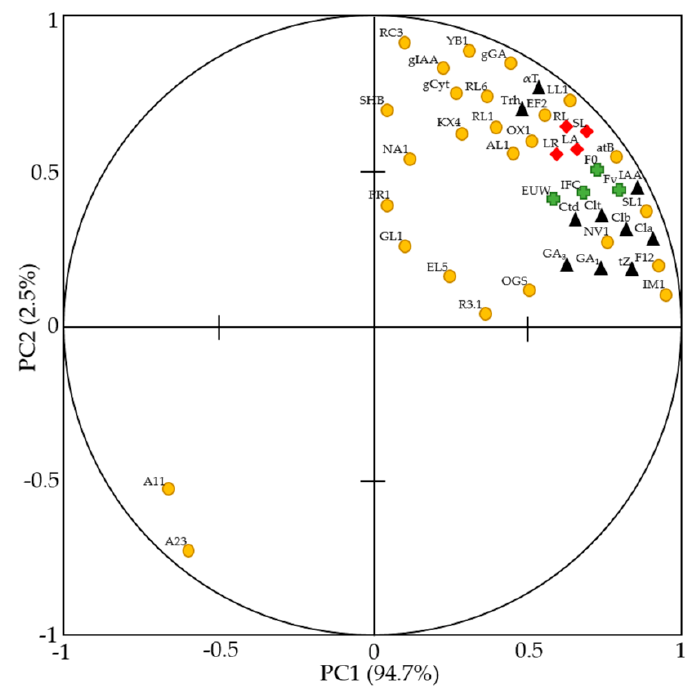
Figure 6. Principal components analysis (PCA) between the shoot and root growth reveals improvement of physiological and biochemical attributes and increased gene expression for phytohormone production and root growth and development. Data are from evaluations performed at 15 days after stress, for red rice plants inoculated with G. diazotrophicus and grown under water stress (50% field capacity. Symbols in red represent the growth parameters, in green represent the physiological parameters, in black represent the parameters of biochemists, and in yellow represent the parameters of gene expression. SL: shoot length; LA: leaf area; RL: root length; LR: lateral roots;